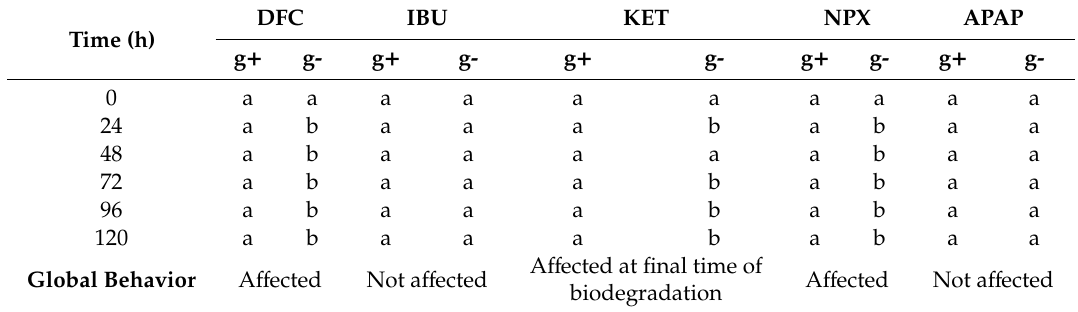
Table 1. Statistical analysis of the influence of glucose supplementation in the biodegradation of NSAIDs / analgesic complex mixture by P. oxalicum.